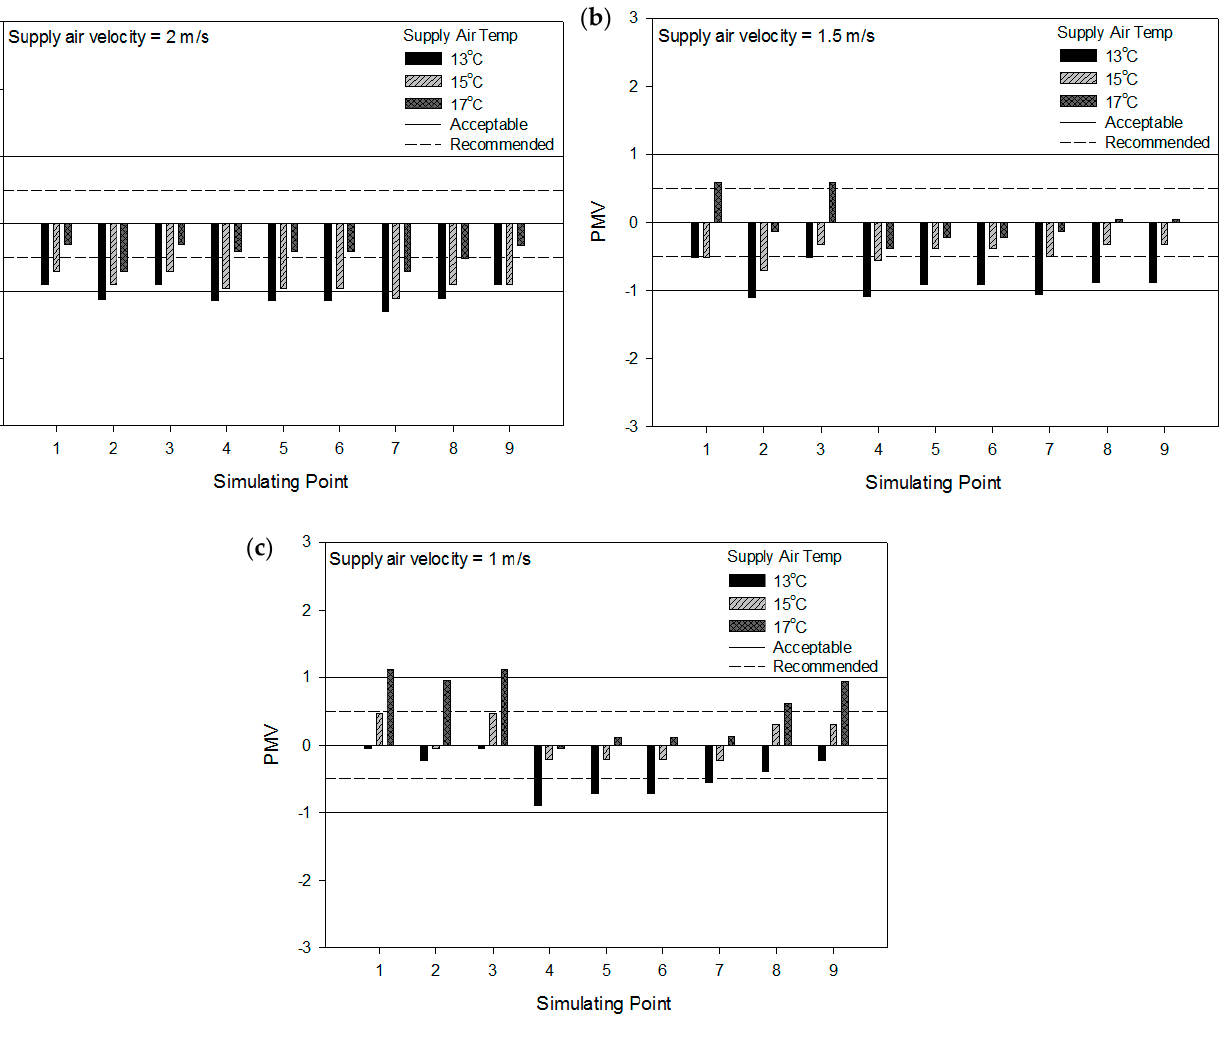
Figure 7. PMV variation results in different temperature and air velocity settings. ( a ) supply air velocity at 2 m/s, ( b ) supply air velocity at 1.5 m/s, and ( c ) supply air velocity at 1 m/s. To find acceptable indoor environment conditions, some parameters of the temperature and air velocity settings were examined. Table 3 shows the results of the PMV index for thermal comfort. It shows the findings from the most comfortable to the most uncomfortable thermal conditions. This study discovered that a temperature setting of 15 °C and air velocity of 1 m/s distributed from supply air grilles to the conference hall could generate a suitable indoor environment for thermal conditions. The PMV value could be kept between − 0.5 and 0.5. According to Espejel-Blanco et al. [40], utilizing a control zone of 0–0.5 PMV index values and calculating comfort zones using the PMV approach results in energy savings of